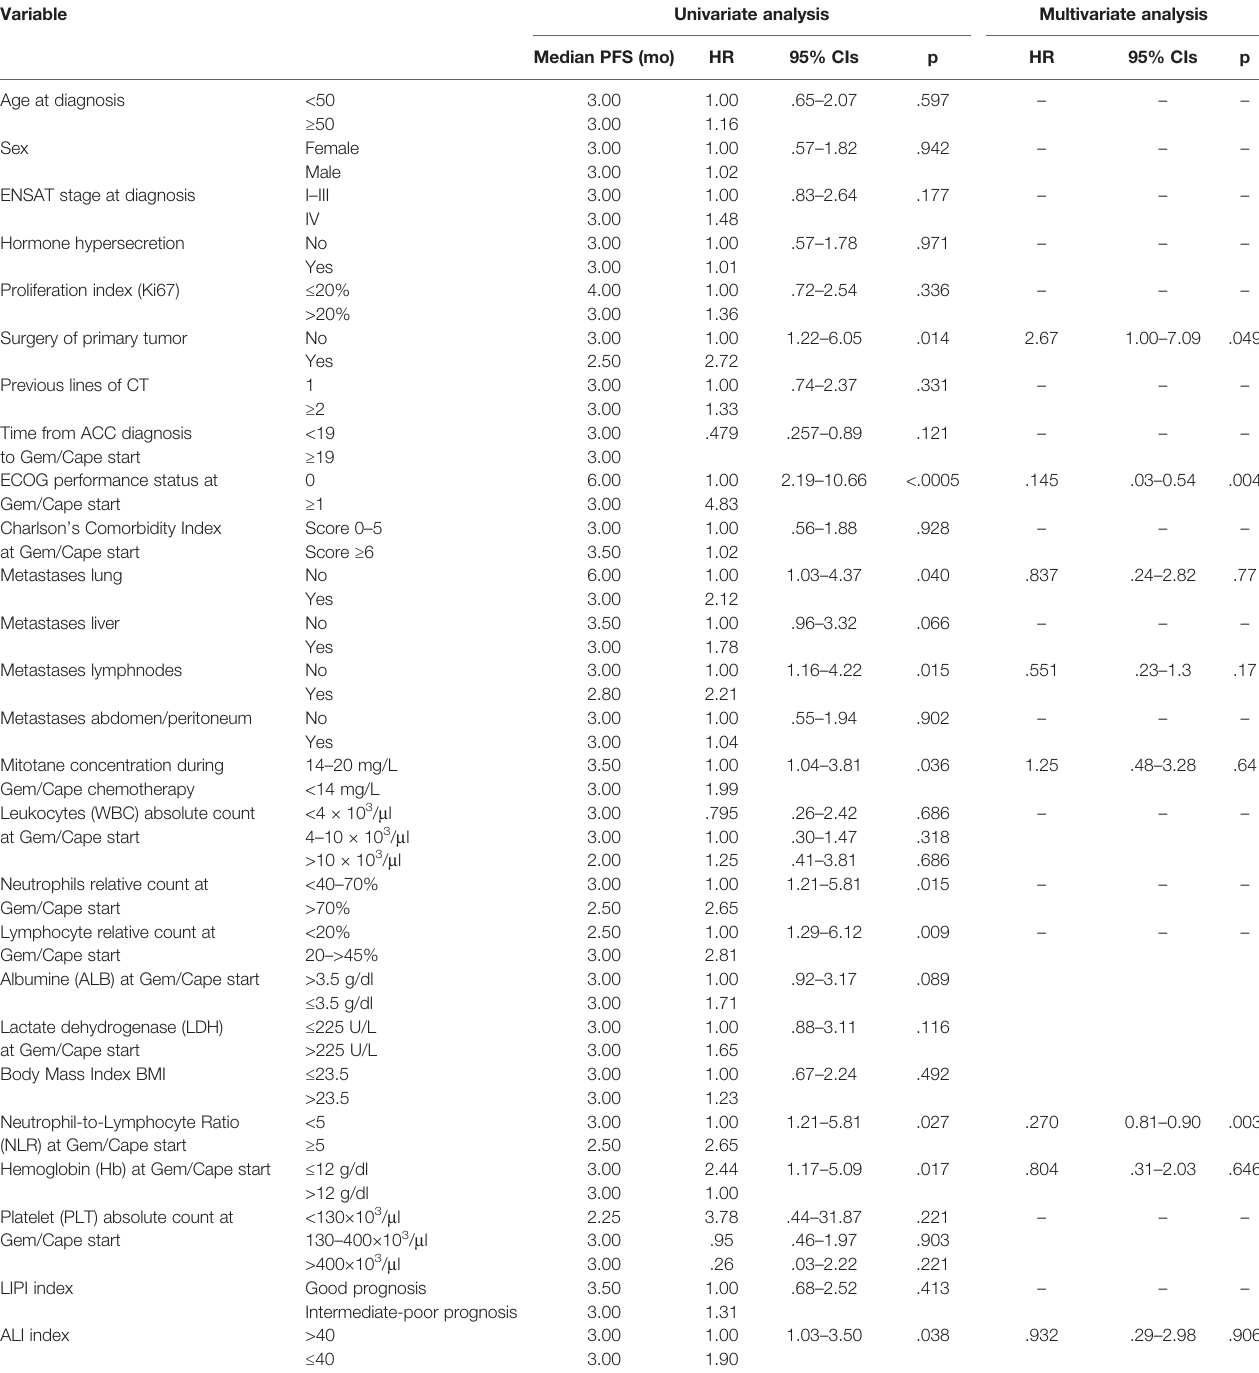
TABLE 3 | Uni- and multivariate analysis of clinico-pathological factors predictive of progression-free survival (PFS).